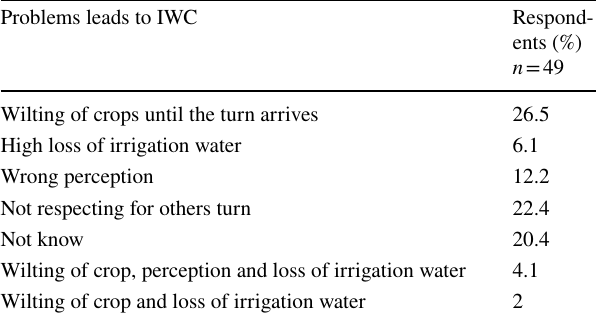
Table 11 Problems that lead to irrigation water conflict in Wondo Genet Catchment area